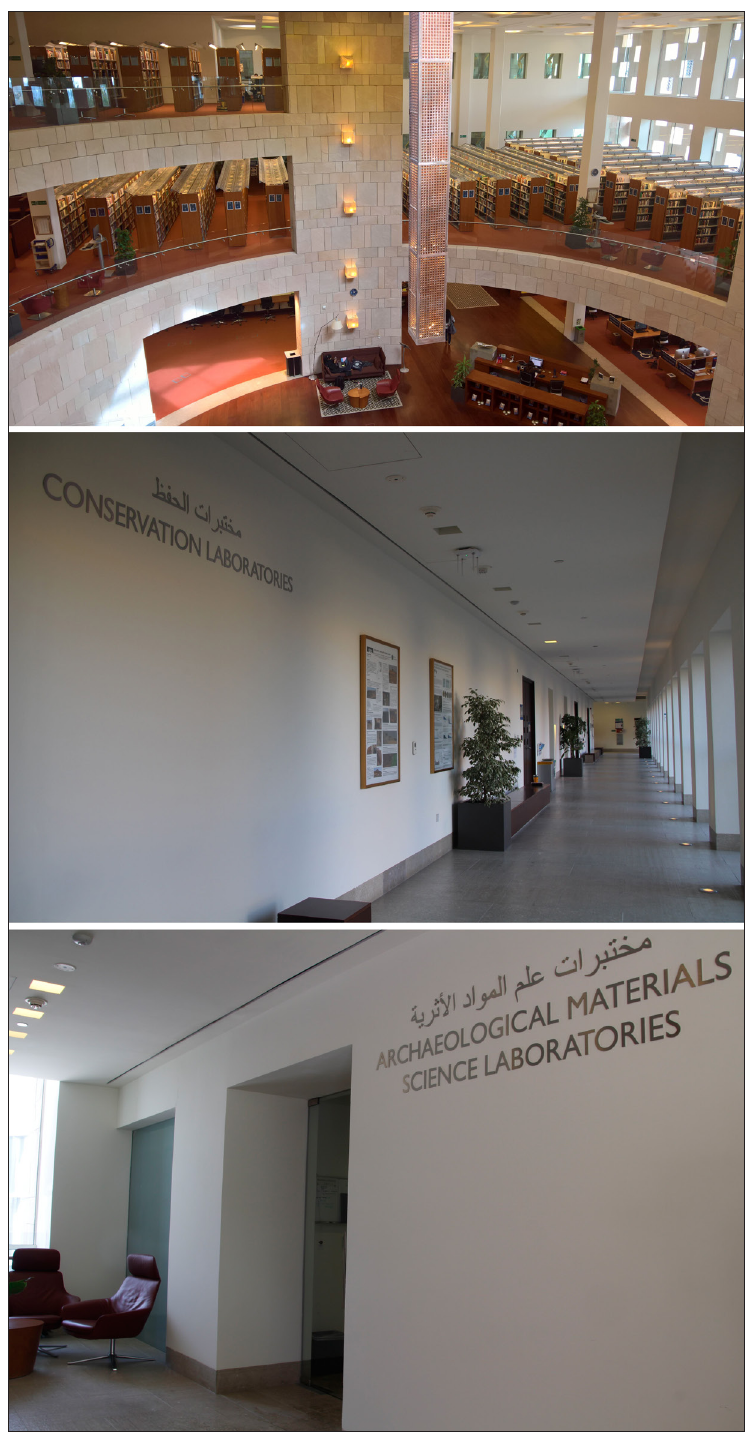
Figure 3: UCL-Q Library, UCL-Q Conservation Labs and UCL-Q Archaeological Materials